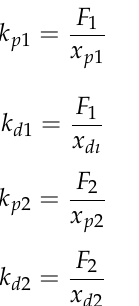
Figure 4. The load and support conditions.